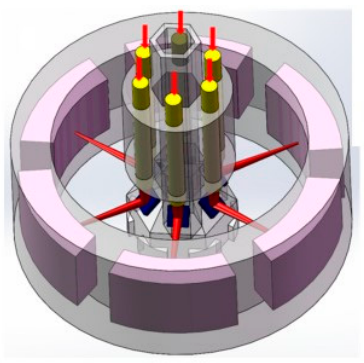
Photonics 2021 , 8 , x FOR PEER REVIEW Figure 23. The schematic of MEMS OCT probe (Figures from [66]). Figure 23. The schematic of MEMS OCT probe (Figures from [66]).